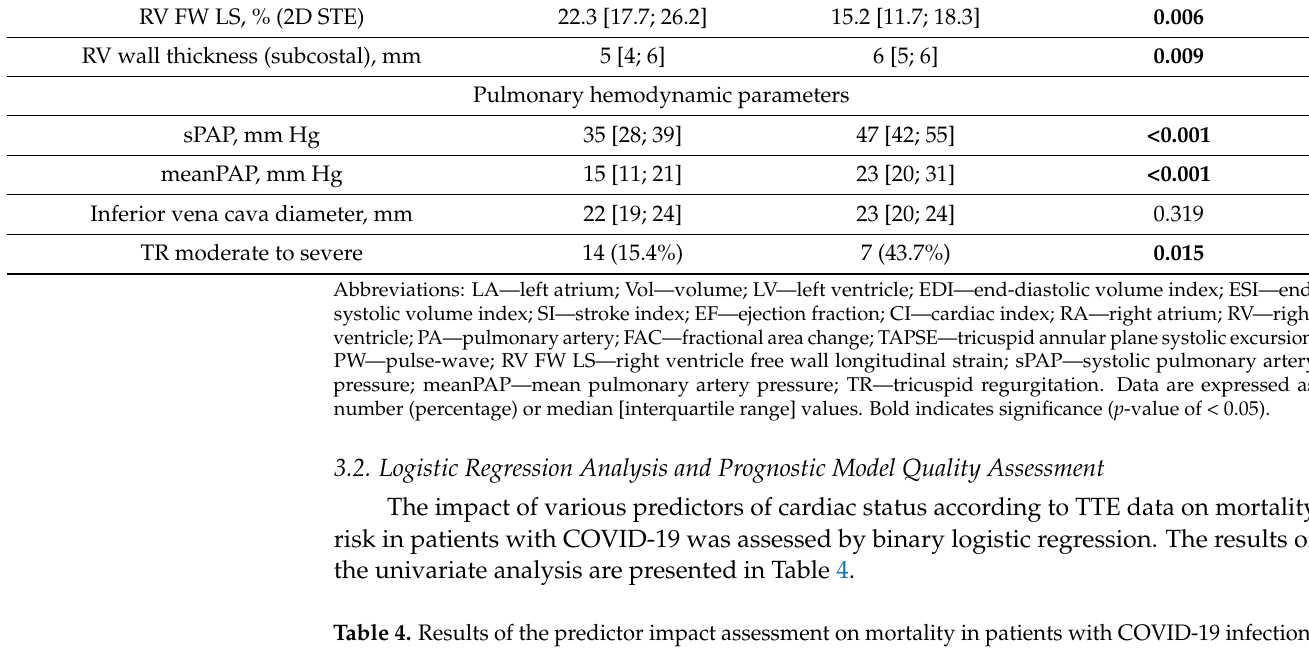
Table 4. Results of the predictor impact assessment on mortality in patients with COVID-19